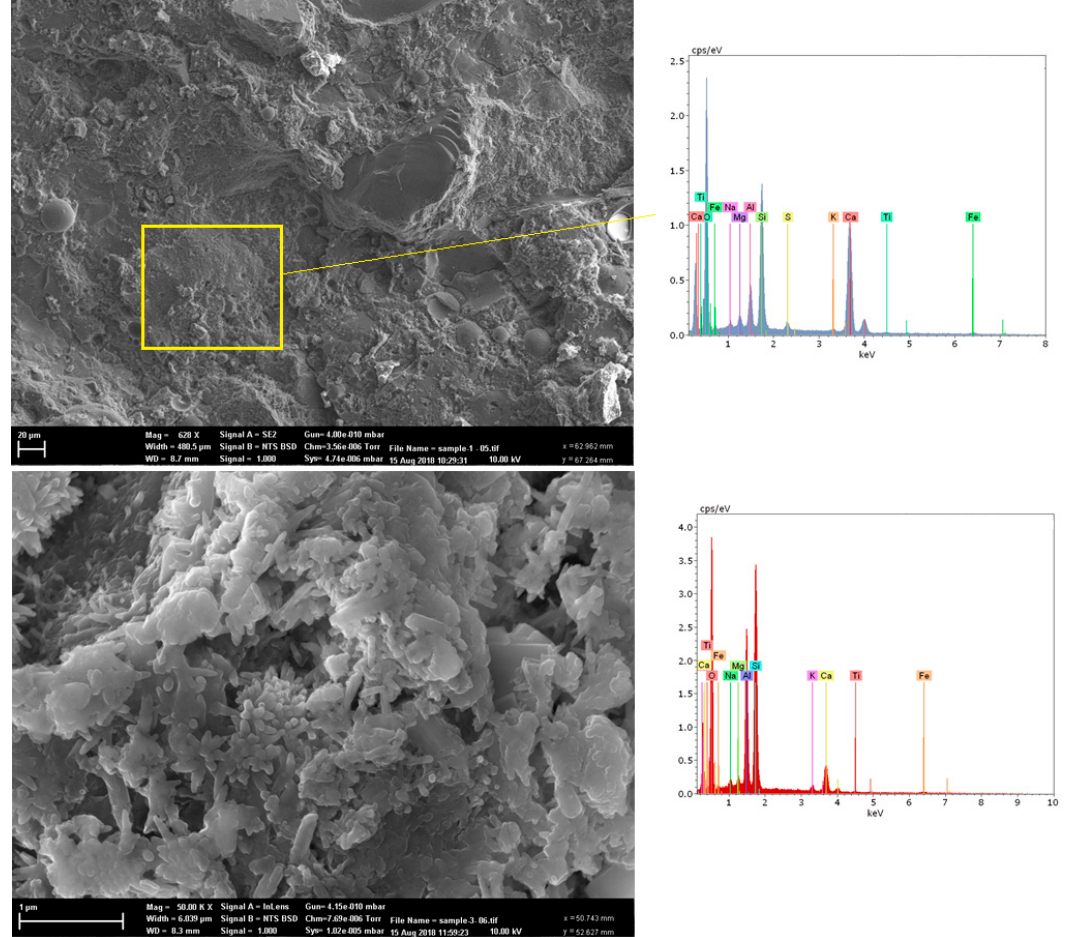
Figure 7. SEM and EDS images of sample containing nano-titanium at different magnifications.